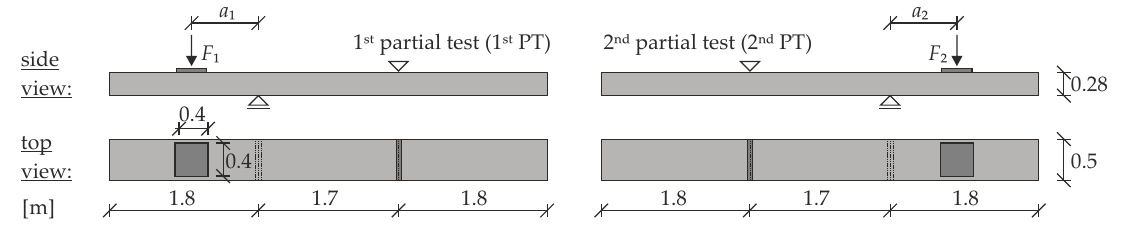
Figure 10. Specimen dimensions and test setup for the large-scale tests on slab segments (graphic by IMB, RWTH Aachen